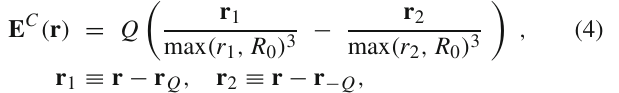
E NP x ( d / 2 , 0 ) isthenonperturbativechromoelectricfield.Fortheparam- eters of the Coulomb fit we quote, along with the statistical error, a sys- tematic uncertainty that accounts for the variability in the values of the fit parameters extracted from all acceptable fits to E y and E z at different x l values (for more details, see Appendix